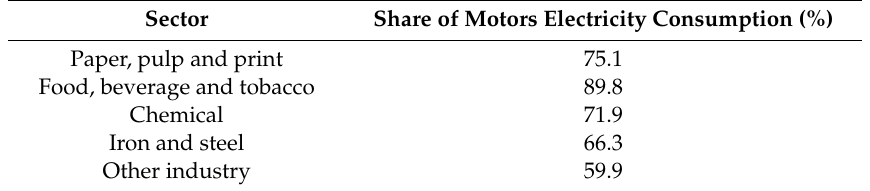
Table 4. Shares of electricity use by industrial sector in the European Union.